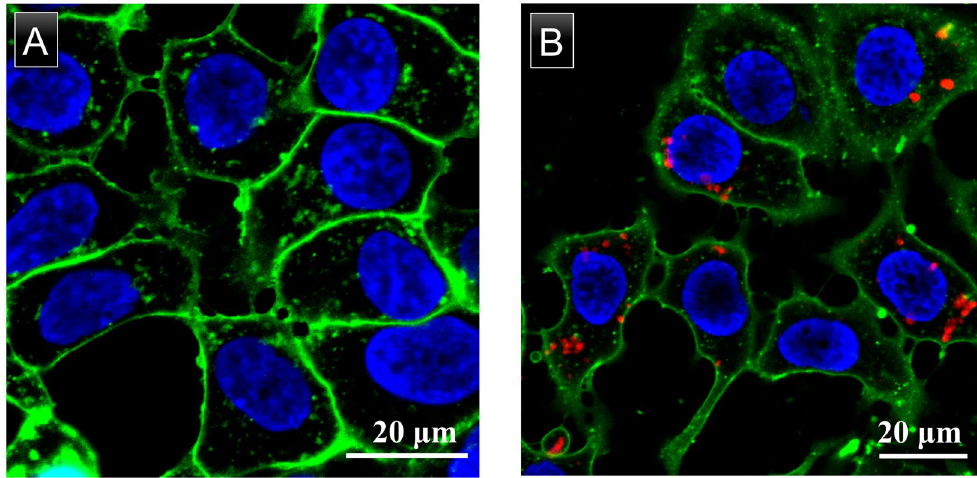
Figure 6. Confocal fluorescence microscopy images of MCF-7 cells treated with ( A ) plain PLGA nanoparticles (control) and ( B ) PLGA nanoparticles labeled with DDA-GSH-AuNCs. Nuclei were stained with Hoechst 33342 (blue color) and cell membranes were stained with CellMask orange (green color). Red pixels are emitted fluorescence of encapsulated DDA-GSH-AuNCs in the dosed PLGA nanocarriers. Scale bars: 20 μ